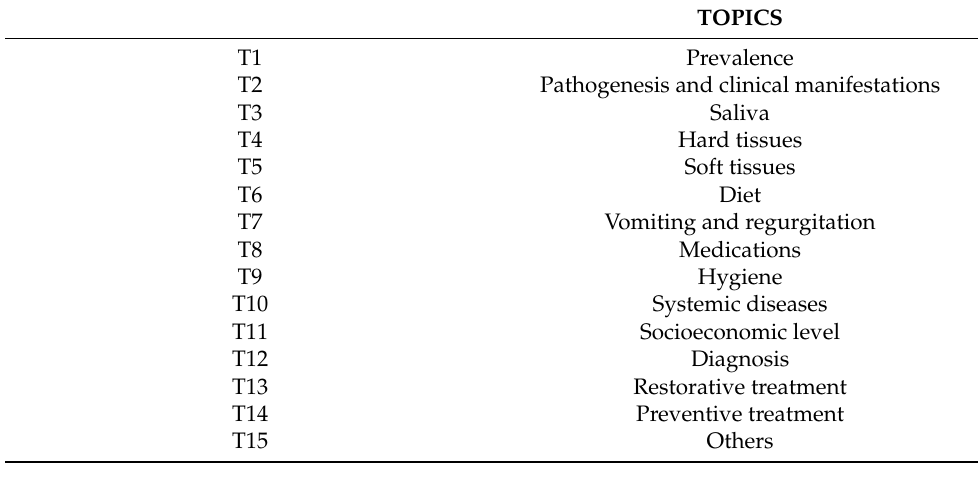
Table 1. Classification of the topics.